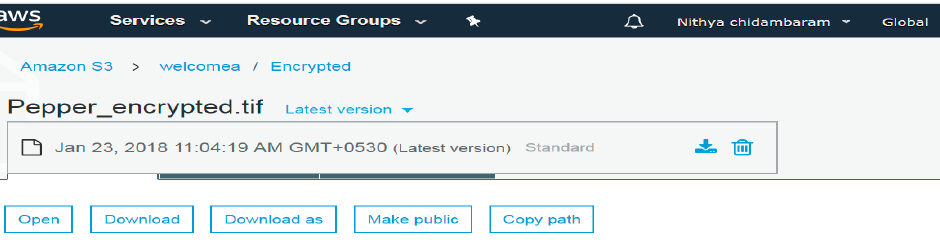
Figure 5. View of the ciphered image in AWS S3 bucket.